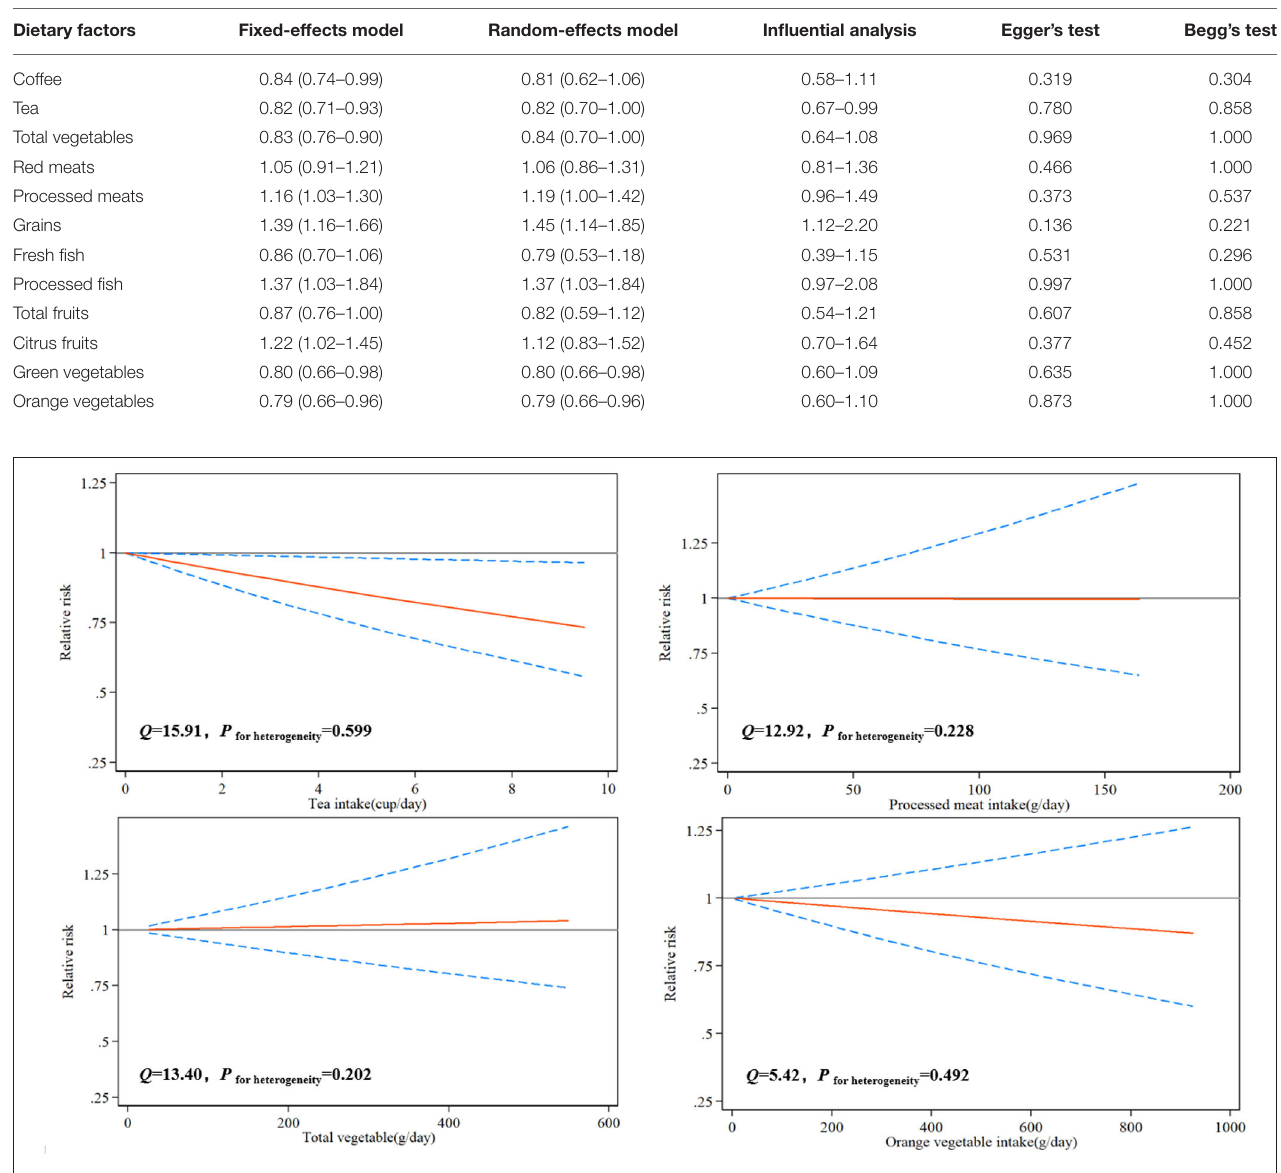
TABLE 4 | Sensitivity analysis and publication bias.